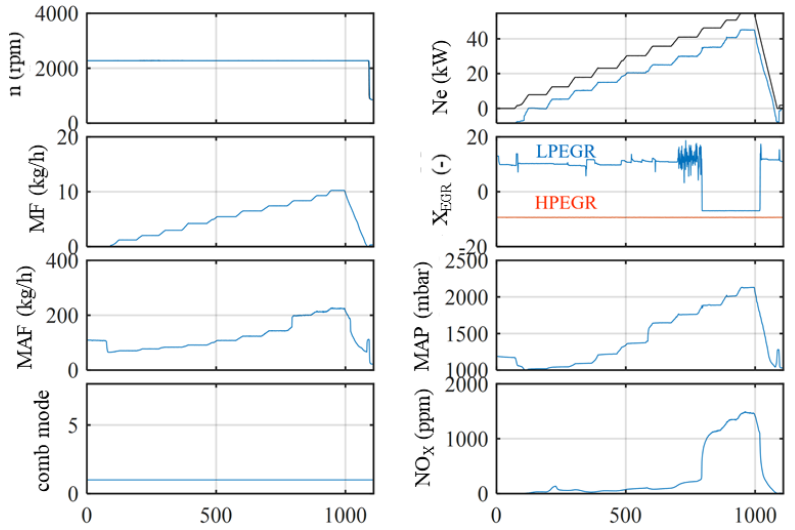
Figure 3. Altitude above sea level and speed limits along the route.